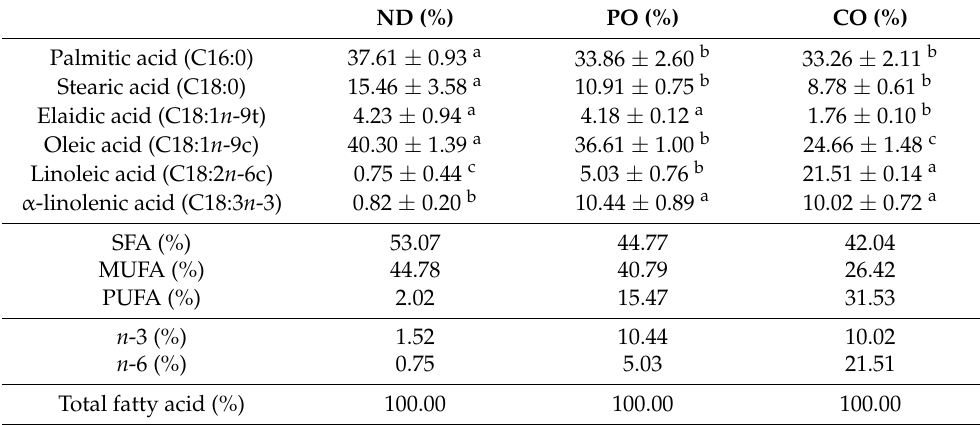
Table 2. Fatty acids profile of experiment diets.